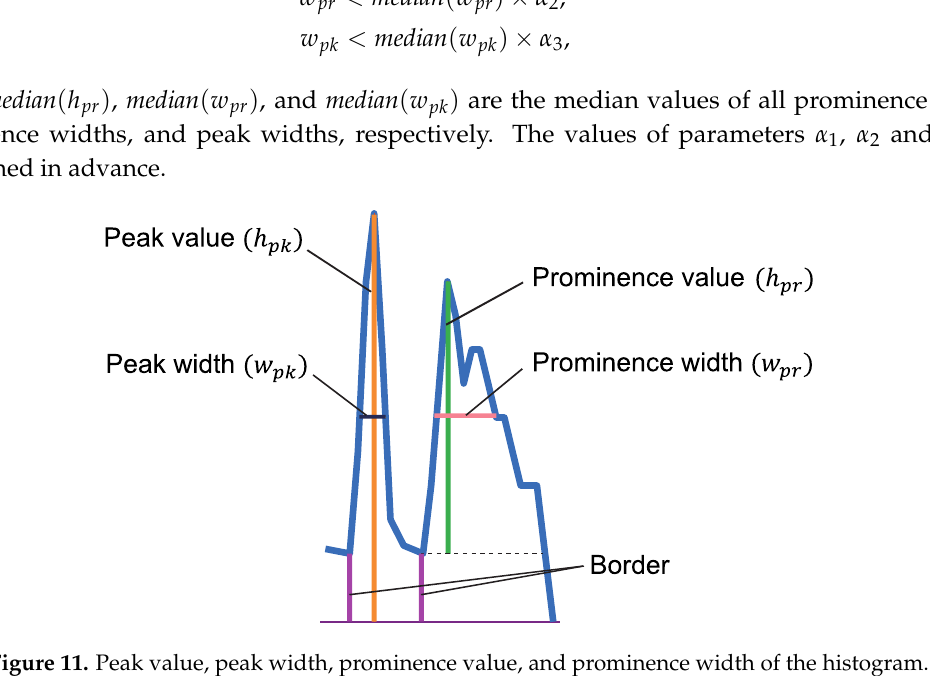
Figure 11. Peak value, peak width, prominence value, and prominence width of the